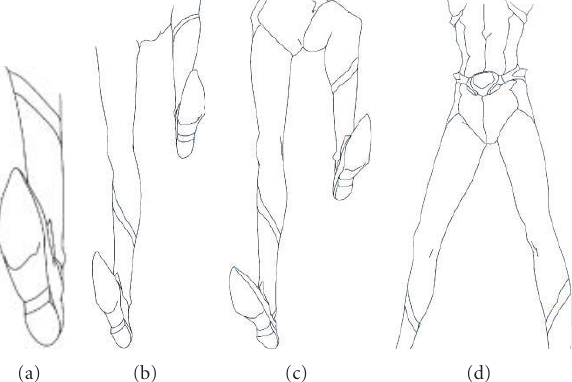
Figure 12: Other frames in the cut used in Test 1 (courtesy of Anime International Co., Inc.,